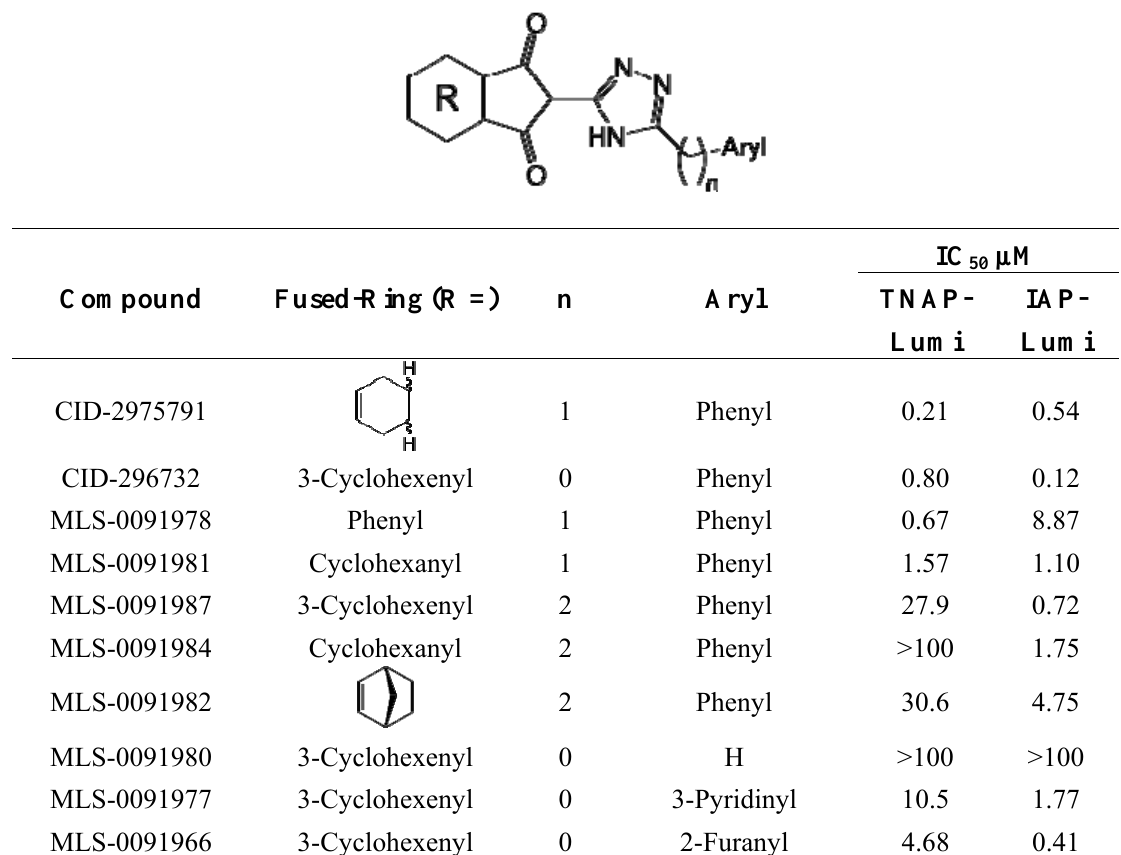
Table 7. SAR and Selectivity of phtalimide triazole inhibitor series.